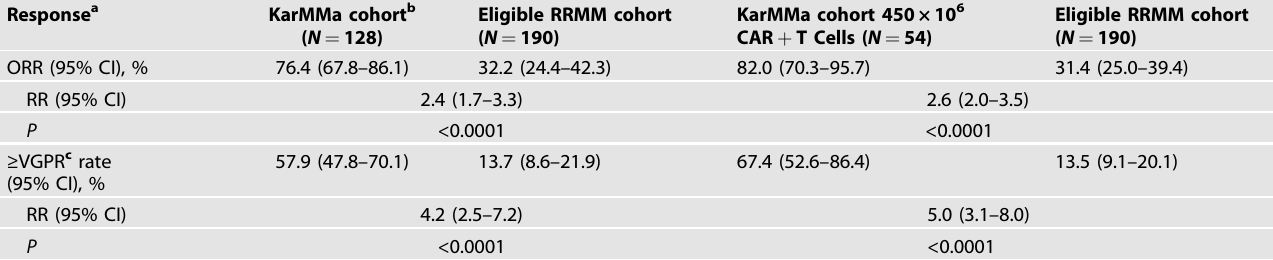
Table 2. Response rates adjusted for stabilized trimmed inverse probability treatment